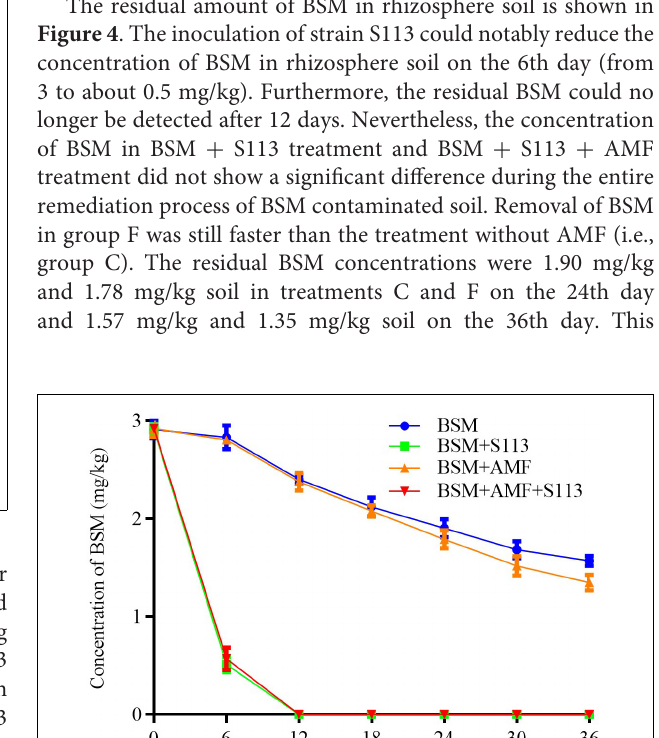
Frontiers in Microbiology |